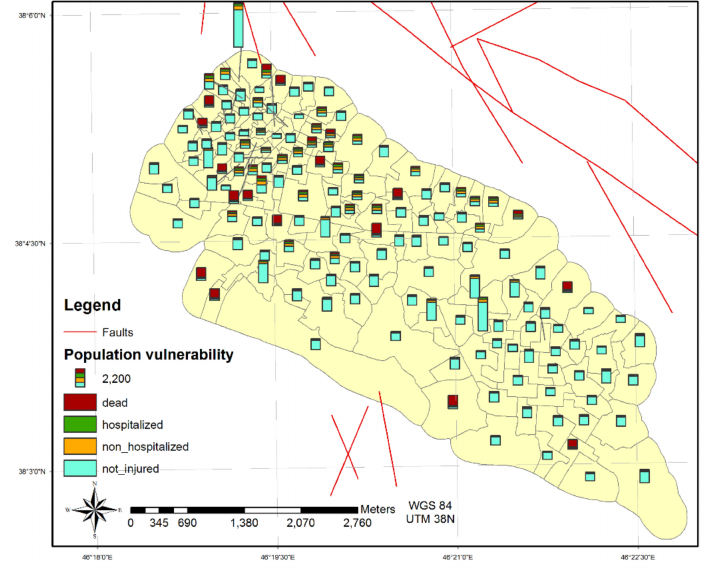
Figure 12. Map of social